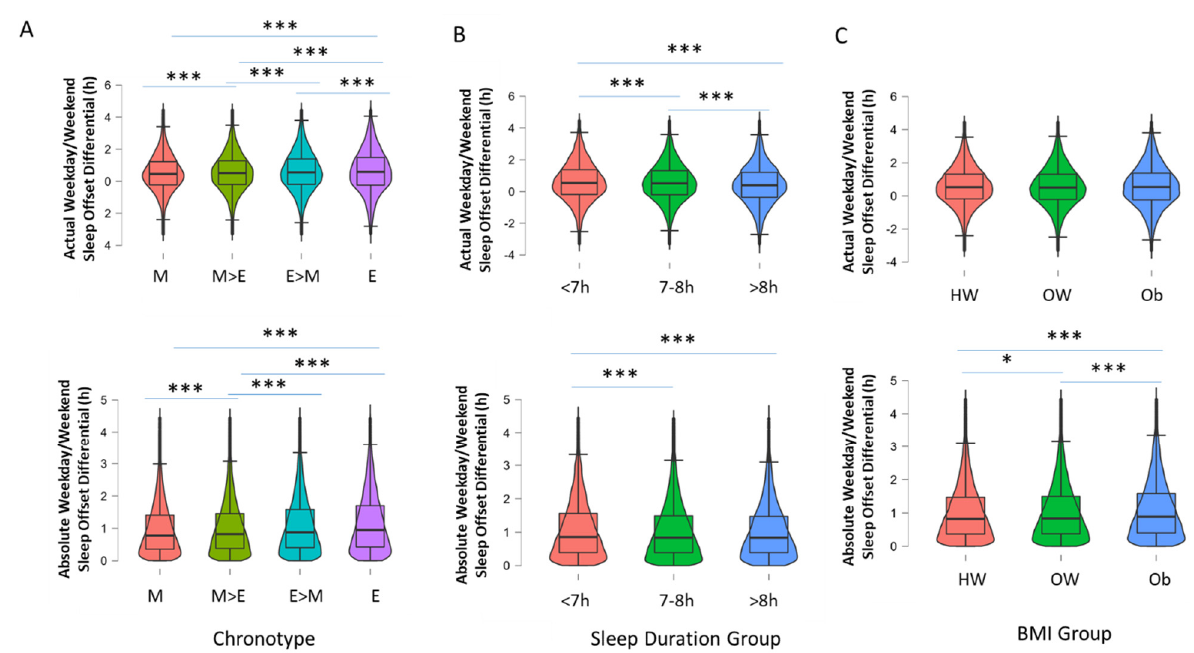
Figure 4. Box-and-violin plots showing ( A ) actual and absolute WD/WE according to chronotype grouping (M = morning, M > E = more morning than evening, E > M = more evening than morning and E = evening); ( B ) actual and absolute WD/WE according to three groups based on self-reported typical sleep duration (<7 h a night, 7–8 h a night, >8 h a night); and ( C ) actual and absolute WD/WE in groups based on BMI (HW = healthy weight, BMI > 19.99 < 24.99, OW = overweight, BMI > 24.99